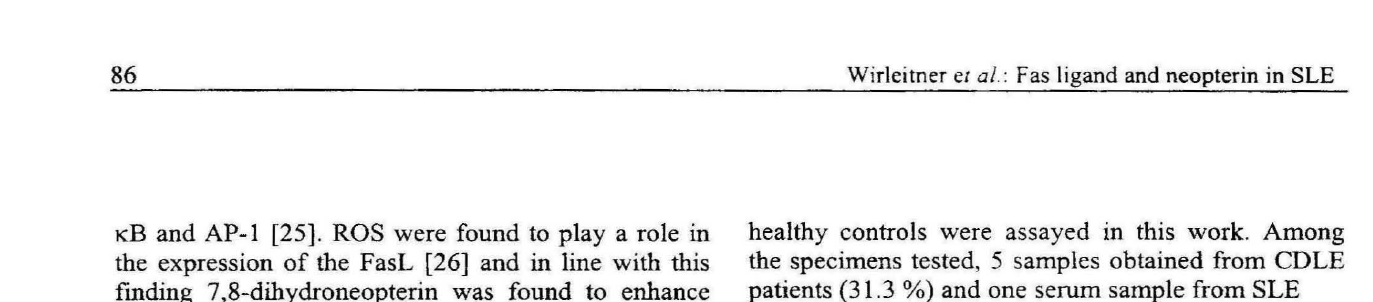
Table 1: Clinical characteristics of patients with SLE and